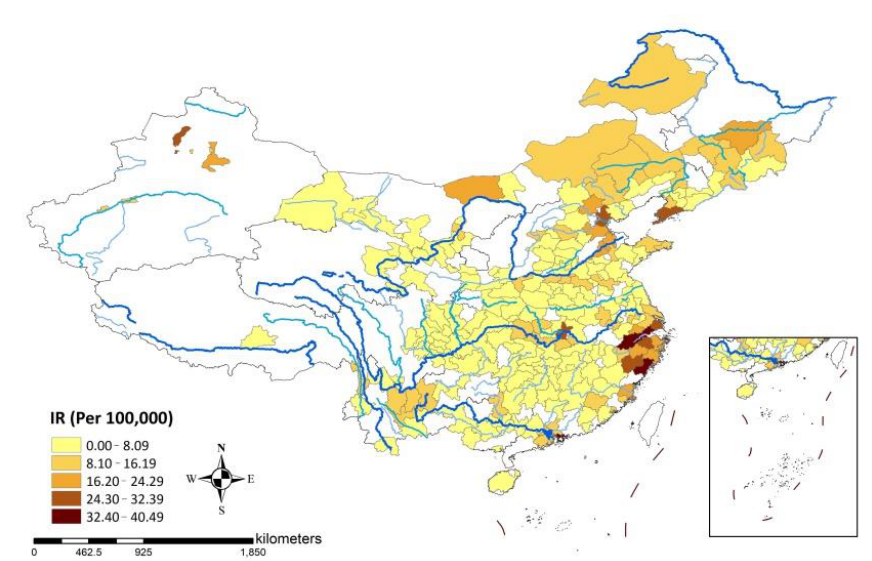
Figure 2. Map of TC incidence (per 100,000) in 2016. Note: The blank areas had no available registration data. The blue lines of different shades and thicknesses represented the water towns. The darker and the thicker the line was, the higher the stream order. The first order stream was the highest order.